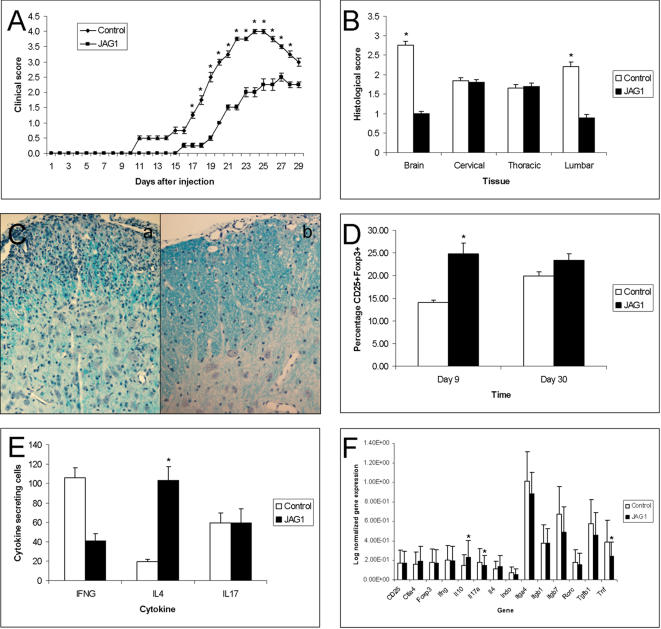
Validation of Jagged1 as a therapeutic target in the animal model of MS:C57B6 mice (n = 60) were immunized with MOG35–55 and treated with Jagged1 agonist peptide i.p. (n = 30) or placebo (n = 30) from day 0 to day 30 in two different experiments. Twelve animals (6 from each treatment group) were sacrificed by day 9 in order to perform immunological studies. Animals treated with the Jagged1 agonist peptide have a clinical (A) and histological (B) score lower than placebo animals. C) Representative spinal cord sections from placebo (a) and jagged1 (b) treated animals stained with Luxol-fast blue showing a decrease in the presence of inflammatory infiltrates and the extend of demyelination in the Jagged1 treated animals. FACS analysis assessing the percentage of CD25+Foxp3+ Treg cells (D) ELISPOT studies assessing the in vitro secretion of Th1 (INFγ), Th2 (IL-4) and Th17 (IL-17) cytokines (E) and real-time PCR (F) studies in splenocytes from Jagged1 treated and untreated mice. D) Mice treated with Jagged1 peptide have higher percentage of Treg cells than placebo animals by day 9 p.i. (p = 0.032), and such difference disappeared by day 30. E) Splenocytes from Jagged1 treated mice expressed higher levels of IL-4, lower levels of IFNγ and similar levels of Il-17 than placebo animals at day 9 p.i. F) Jagged1 treated animals expressed higher levels of IL-10 and lower levels of TNFα and IL-17 than placebo animals at day 9 p.i. Results are expressed as the mean±SEM